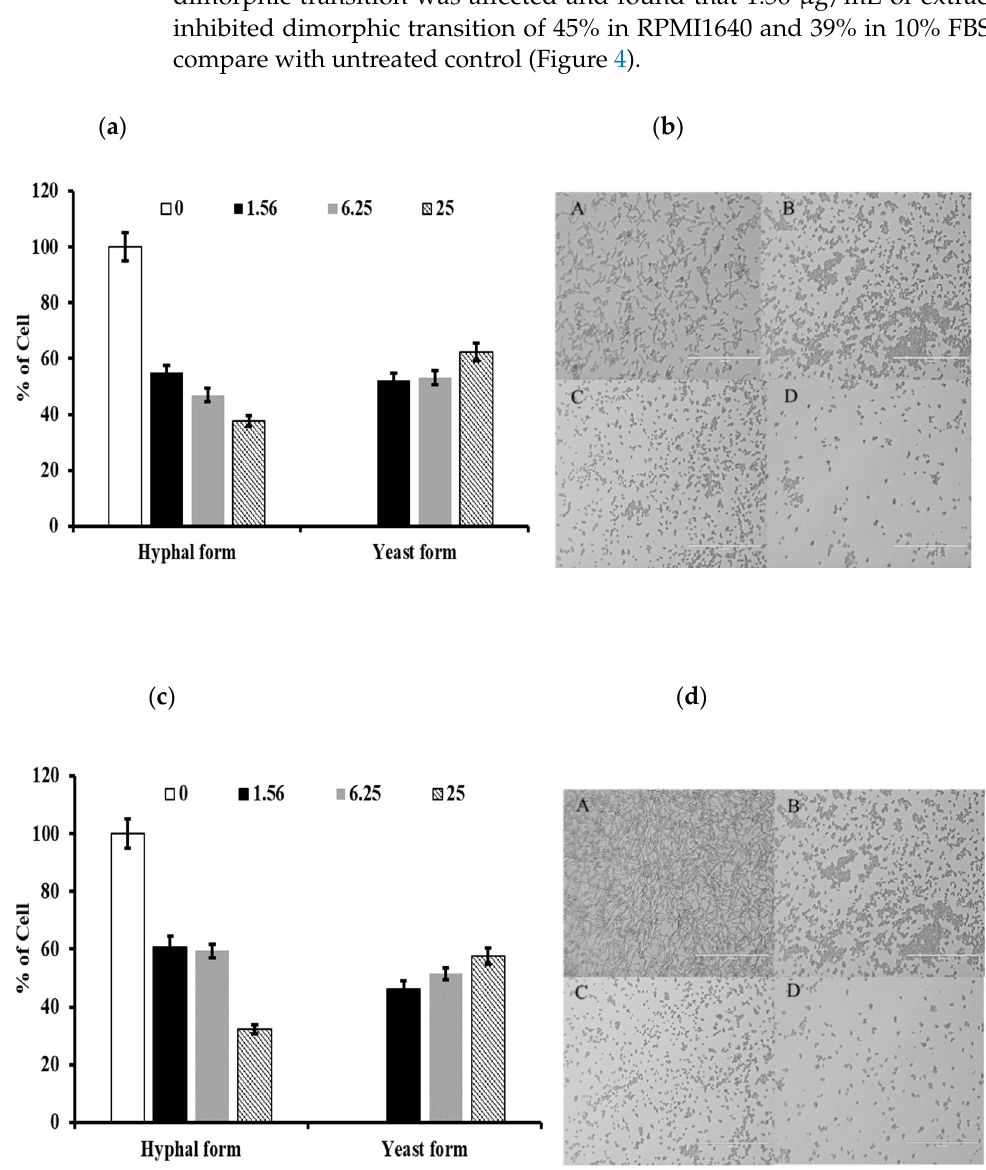
Figure 4. Inhibition of C. albicans dimorphic transition by A. triphylla var. japonica extracts. ( a ) RPMI 1640 was used to induce C. albicans dimorphic transition and ( b ) images of C. albicans cells were obtained using a microscope. A: C. albicans without extract, B: C. albicans treated with 1.56 µ g/mL of extract, C: C. albicans treated with 6.25 µ g/mL of extract, D: C. albicans treated with 25 µ g/mL of extract. ( c ) 10% FBS YPD medium was used to induce C. albicans dimorphic transition and ( d ) images of C. albicans cells were obtained using a microscope. A: C. albicans without extract, B: C. albicans treated with 1.56 μ g/mL of extract, C: C. albicans treated with 6.25 μ g/mL of extract, D: C. albicans treated with 25 μ g/mL of extract. Experiments were performed in triplicate.